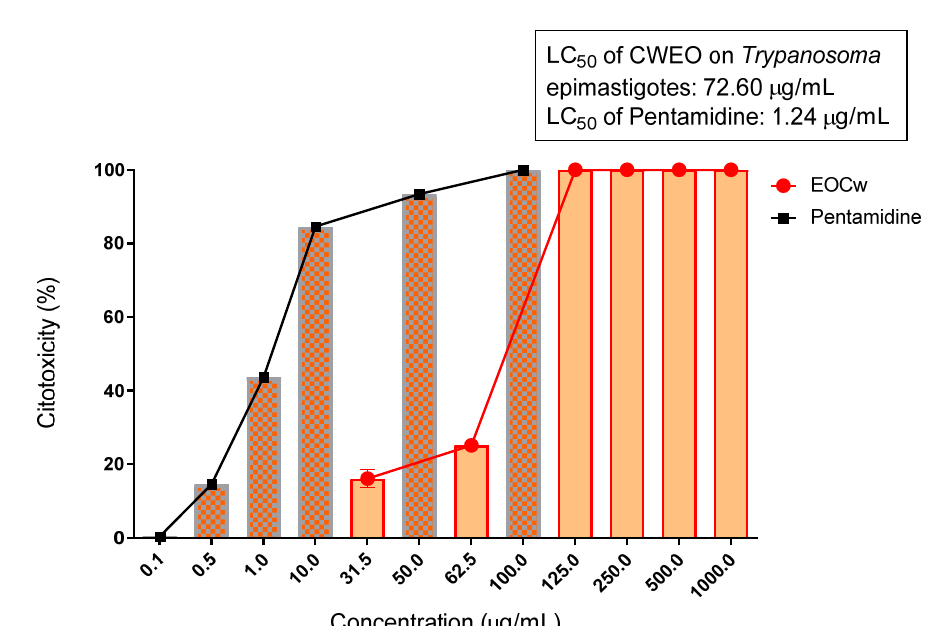
Figure 3. Cytotoxicity of the promastigote L. brasiliensis treated with essential oil of C. winterianus. LC 50 , with the confidence interval for oil at 95% (35.55–56.92). LC 50 was obtained through non-linear regression of means.